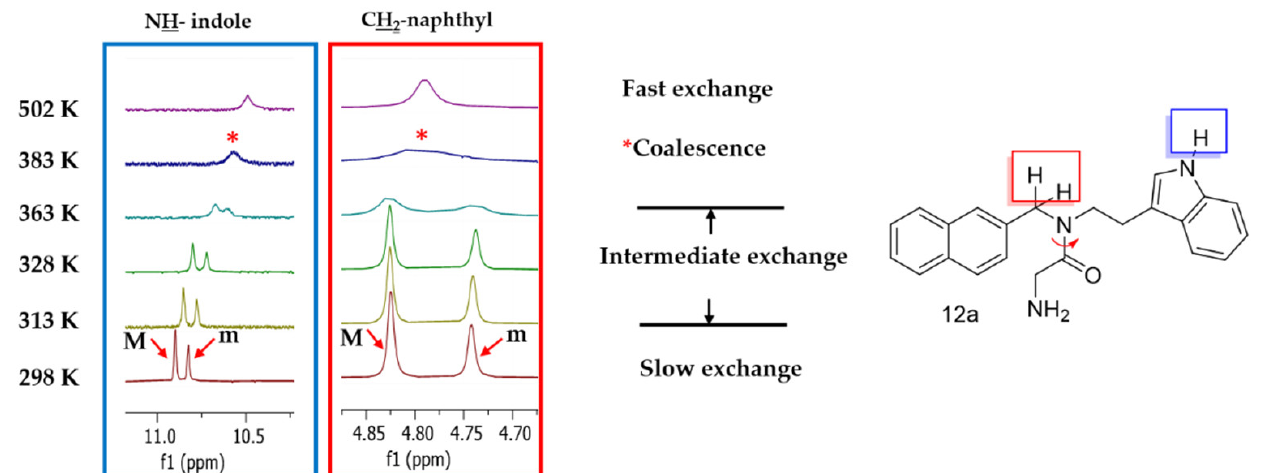
Figure 4. The 1 H NMR spectra of compound 12a at variable temperatures (298–502 K) in DMSO-d 6 .